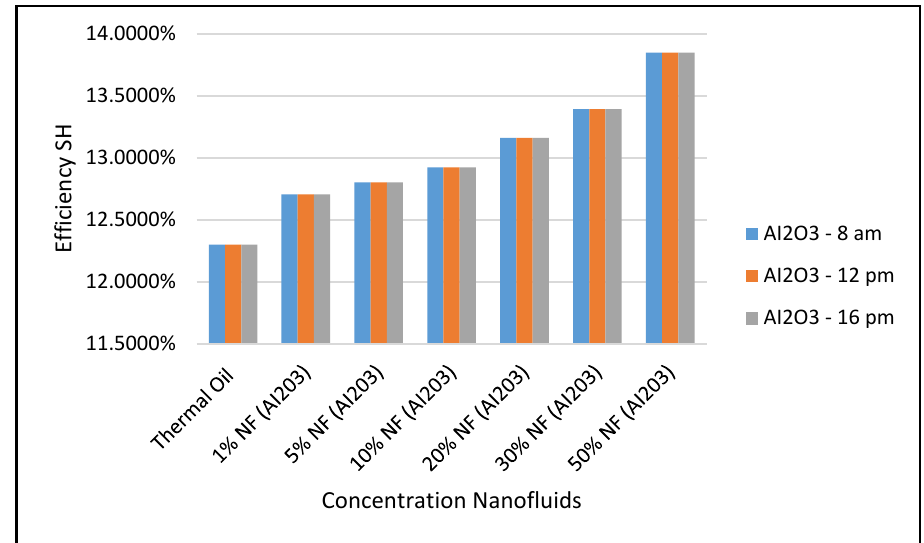
Figure 17. E ffi ciencies of the CSP hybrid system at di ff erent concentrations of Al 2 O 3 Figure 17. Efficiencies of the CSP hybrid system at different concentrations of Al 2 O 3 .